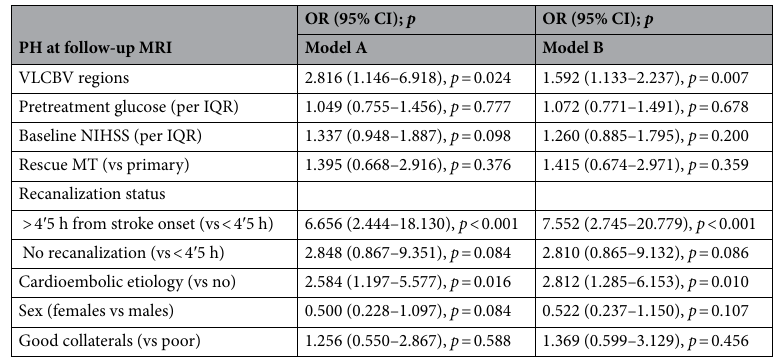
Table 2. Predictors of parenchymal hematoma: multivariate analysis. Very low cerebral blood volume (VLCBV) was included as a dichotomic variable (yes vs no) in model A, and as a continuous quantitative variable (estimations per IQR of VLCBV increase) in model B. MT: Mechanical thrombectomy; NIHSS: National Institutes of Health Stroke Scale; PH: parenchymal hematoma. The Hosmer–Lemeshow test showed an adequate goodness-of-fit of the final models (Model A: X2 = 4.028, p = 0.855; Model B: X2 = 9.329, p = 0.315), and the models classified correctly a total of 84% (Model A) and 85% (Model B) of cases.